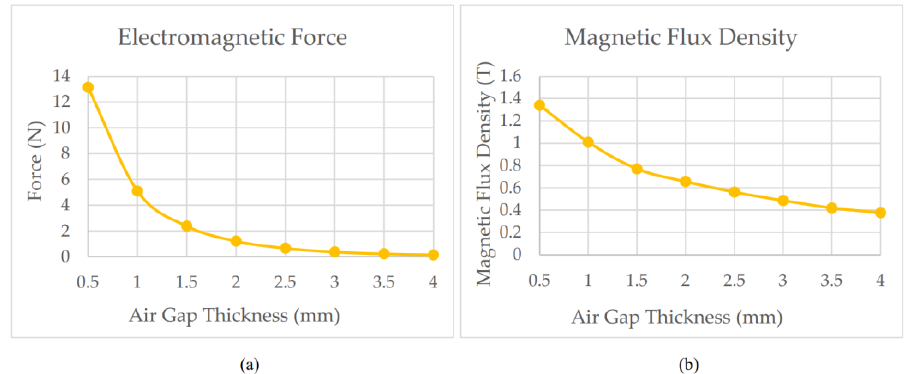
Figure 8. Reaction due to air gap thickness. ( a ) Electromagnetic force. ( b ) Magnetic flux density at the center of the air gap region.